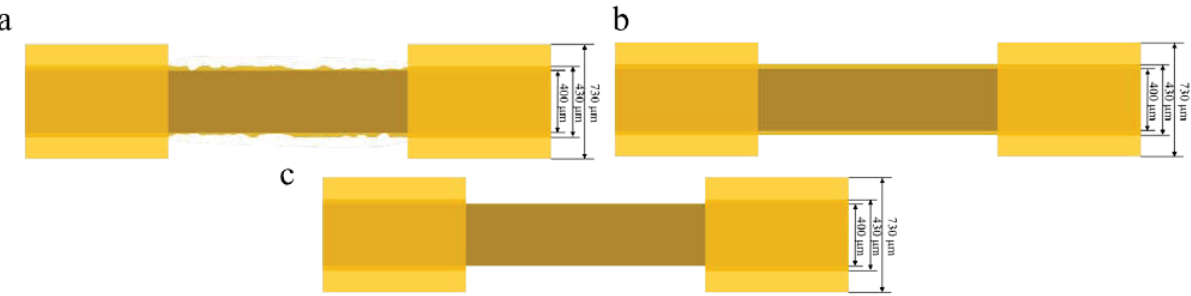
Figure 5. Schematic of an optical fiber cable: ( a ) partially removed; ( b ) insufficiently removed; and ( c ) completely removed.